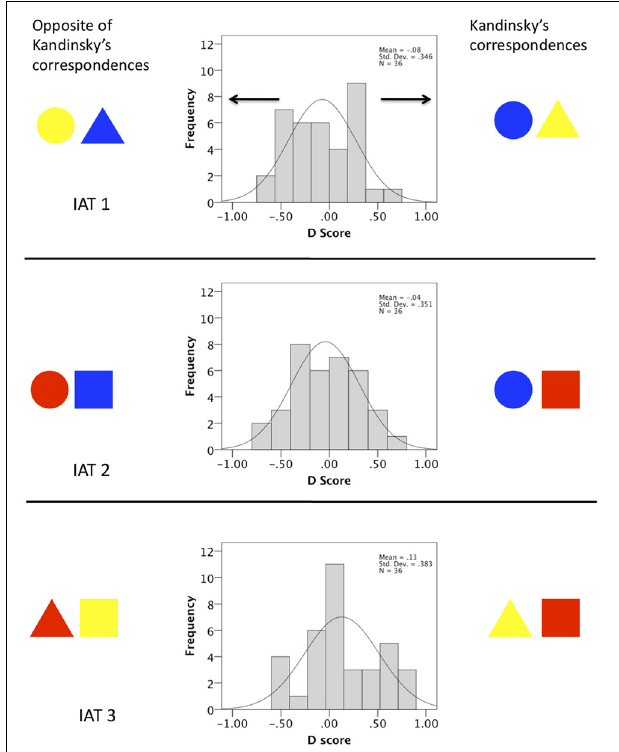
FIGURE 2 | Results of three IAT experiments designed to measure color-form correspondence theory. Positive D scores reflect faster performance in congruent blocks. The Histogram shows the number of participants with D scores within a given range. In IATs 1 and 2 the 36 D scores were normally distributed around zero. In IAT 3 there was a marginally significant shift the right, meaning that on average, participants associated yellow with triangle and red with square compared to the opposite, in line with Kandinsky’s theory.